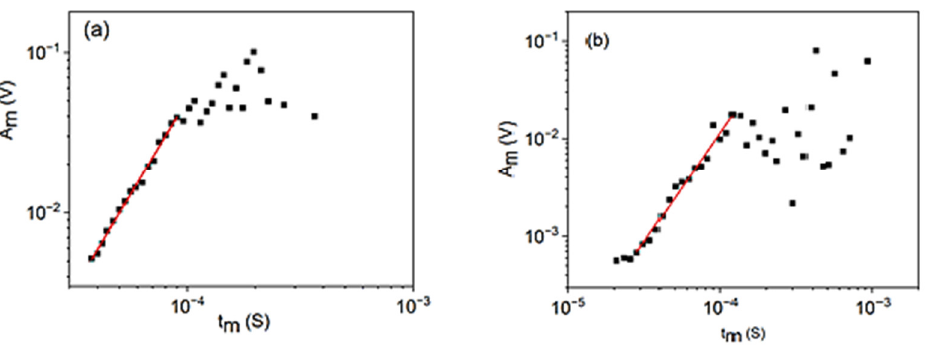
Figure 1. logA m versus logt m plots for cooling in alloy A ( a ) at small, constant, external magnetic field (B = 250 mT) and for heating in alloy B ( b ) (at B = 0).